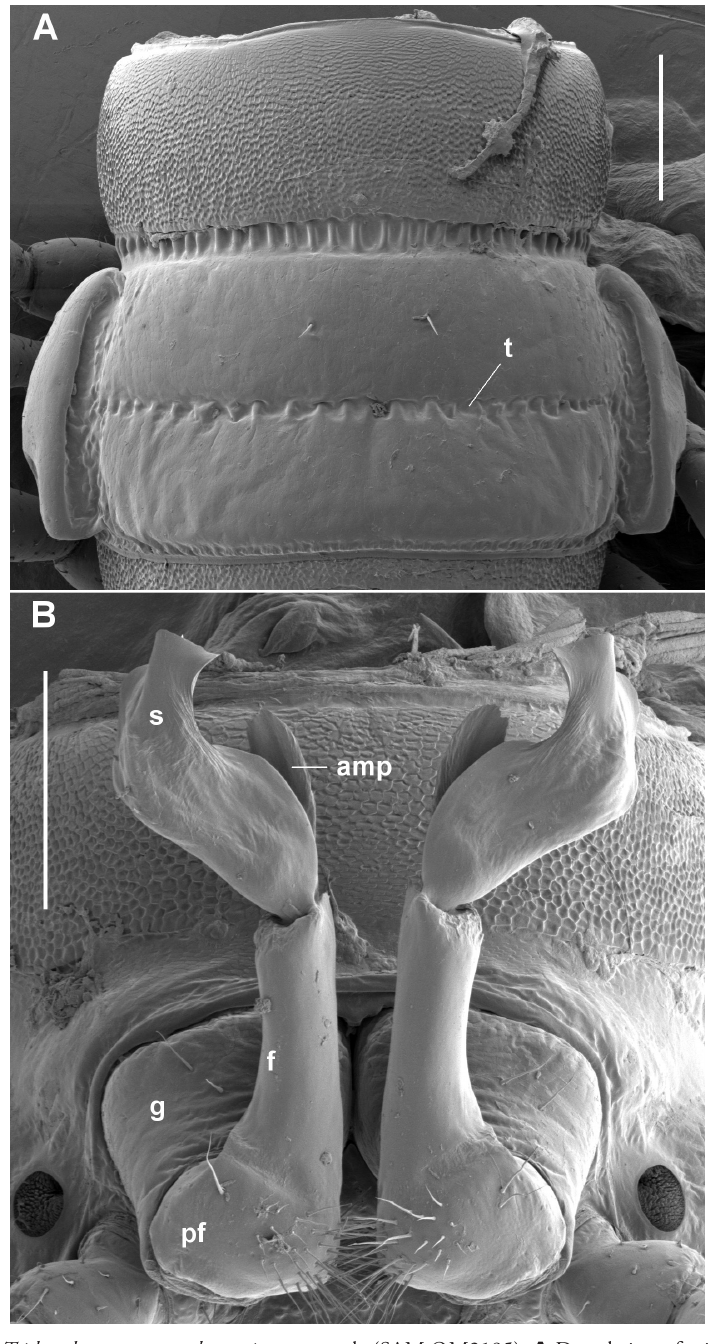
Figure 3. Tridactylogonus warrenbenensis sp. n., male (SAM OM2195). A Dorsal view of midbody ring; t = transverse furrow B Ventral view of gonopods in situ; amp = anteromedial process, f = femoral portion, g = gonocoxa, pf = prefemoral portion of telopodite, s = solenomere. Scale bars: 0.25